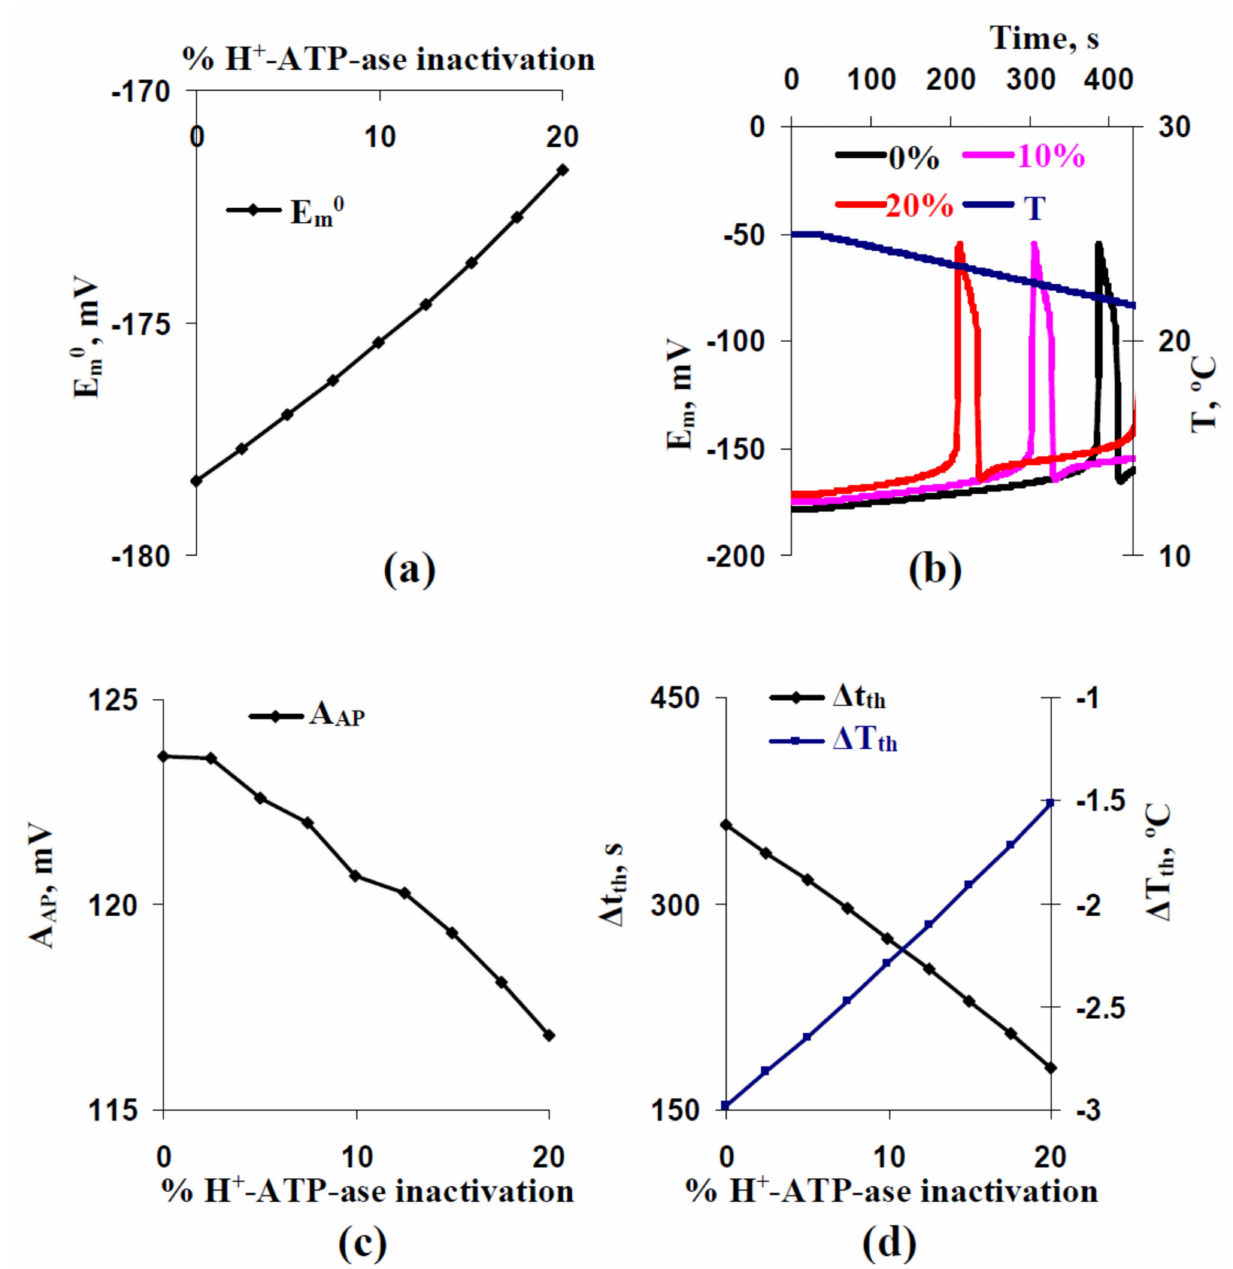
Figure 6. ( a ) Dependence of E m0 on percentage of H + -ATP-ase inactivation, ( b ) examples of simulated changes in E m induced by the T decrease with a 0.5 ◦ C min − 1 rate at 0%, 10%, and 20% H + -ATP-ase inactivation, and ( c ) dependence of A AP and ( d ) both ∆ t th and ∆ T th on the percentage of H + -ATP-ase inactivation. The percentage of H + -ATP-ase inactivation shows a relative decrease of concentration of H + -ATP-ase in comparison to the control value (0% H + -ATP-ase